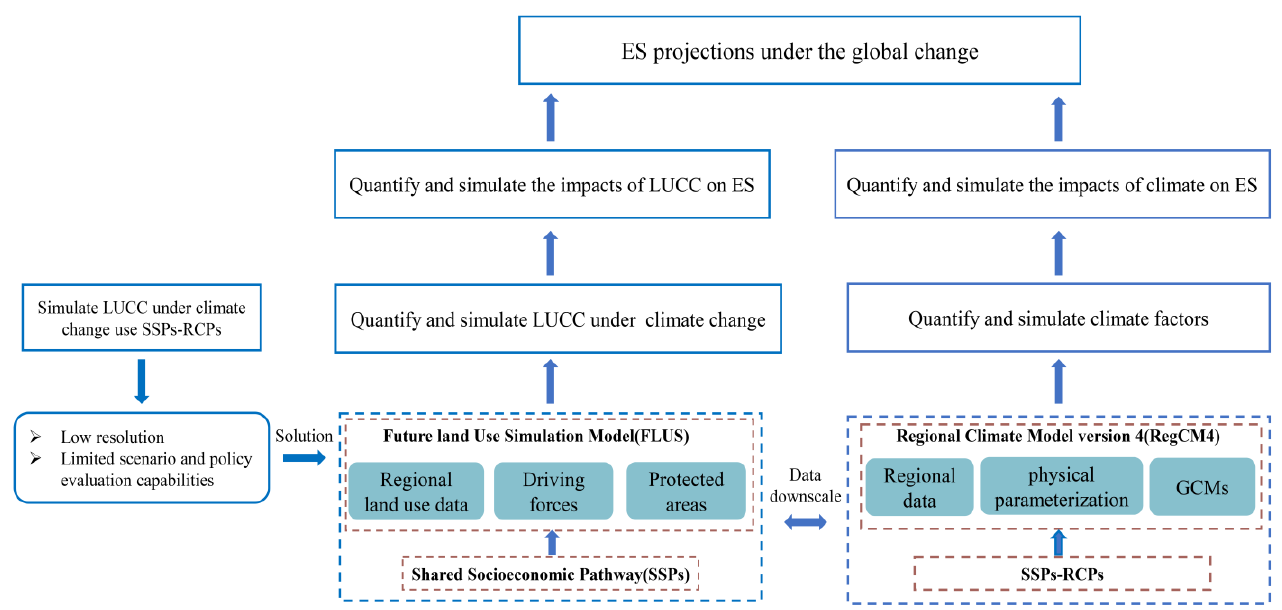
Figure 4. The challenges and solutions of quantitative assessment and simulation of effects of climate and land-use change on variations in ecosystem services.